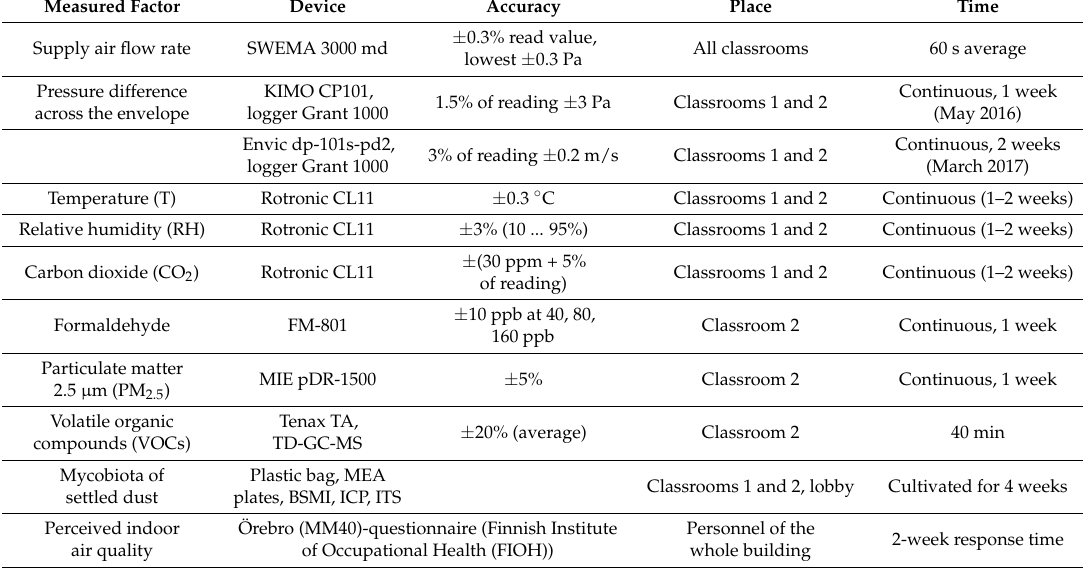
Table 1. Measurement methods, devices, and their accuracy, measurement place, and